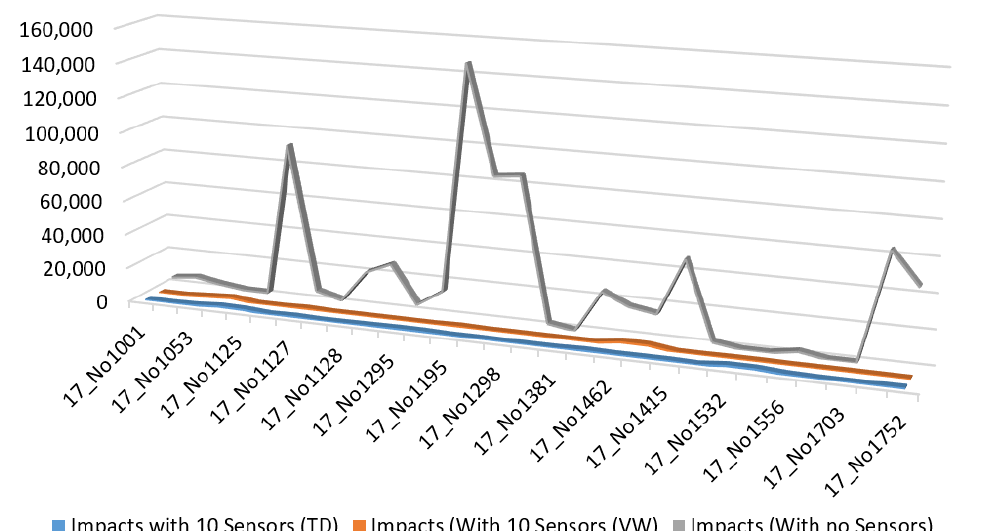
Figure 13. Comparison of the health impact for three